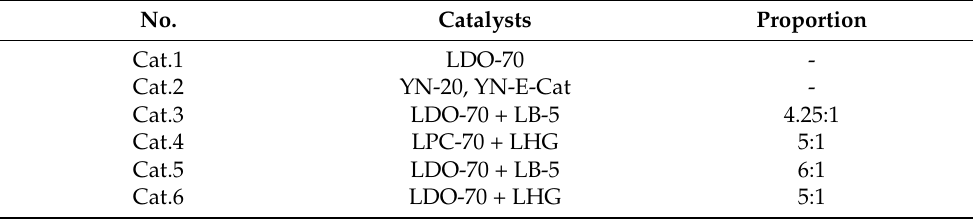
Table 2. Selected fluid catalytic cracking (FCC) catalysts and their compounded proportion.